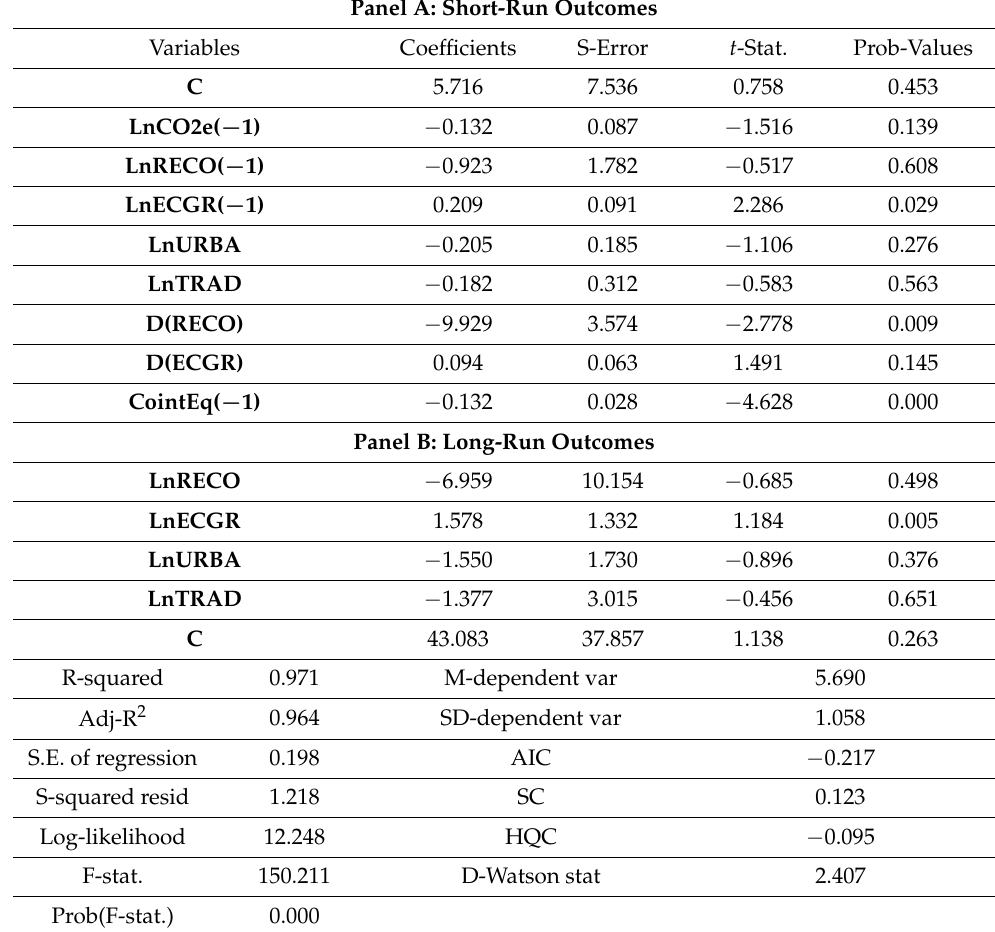
Table 9. Short- and